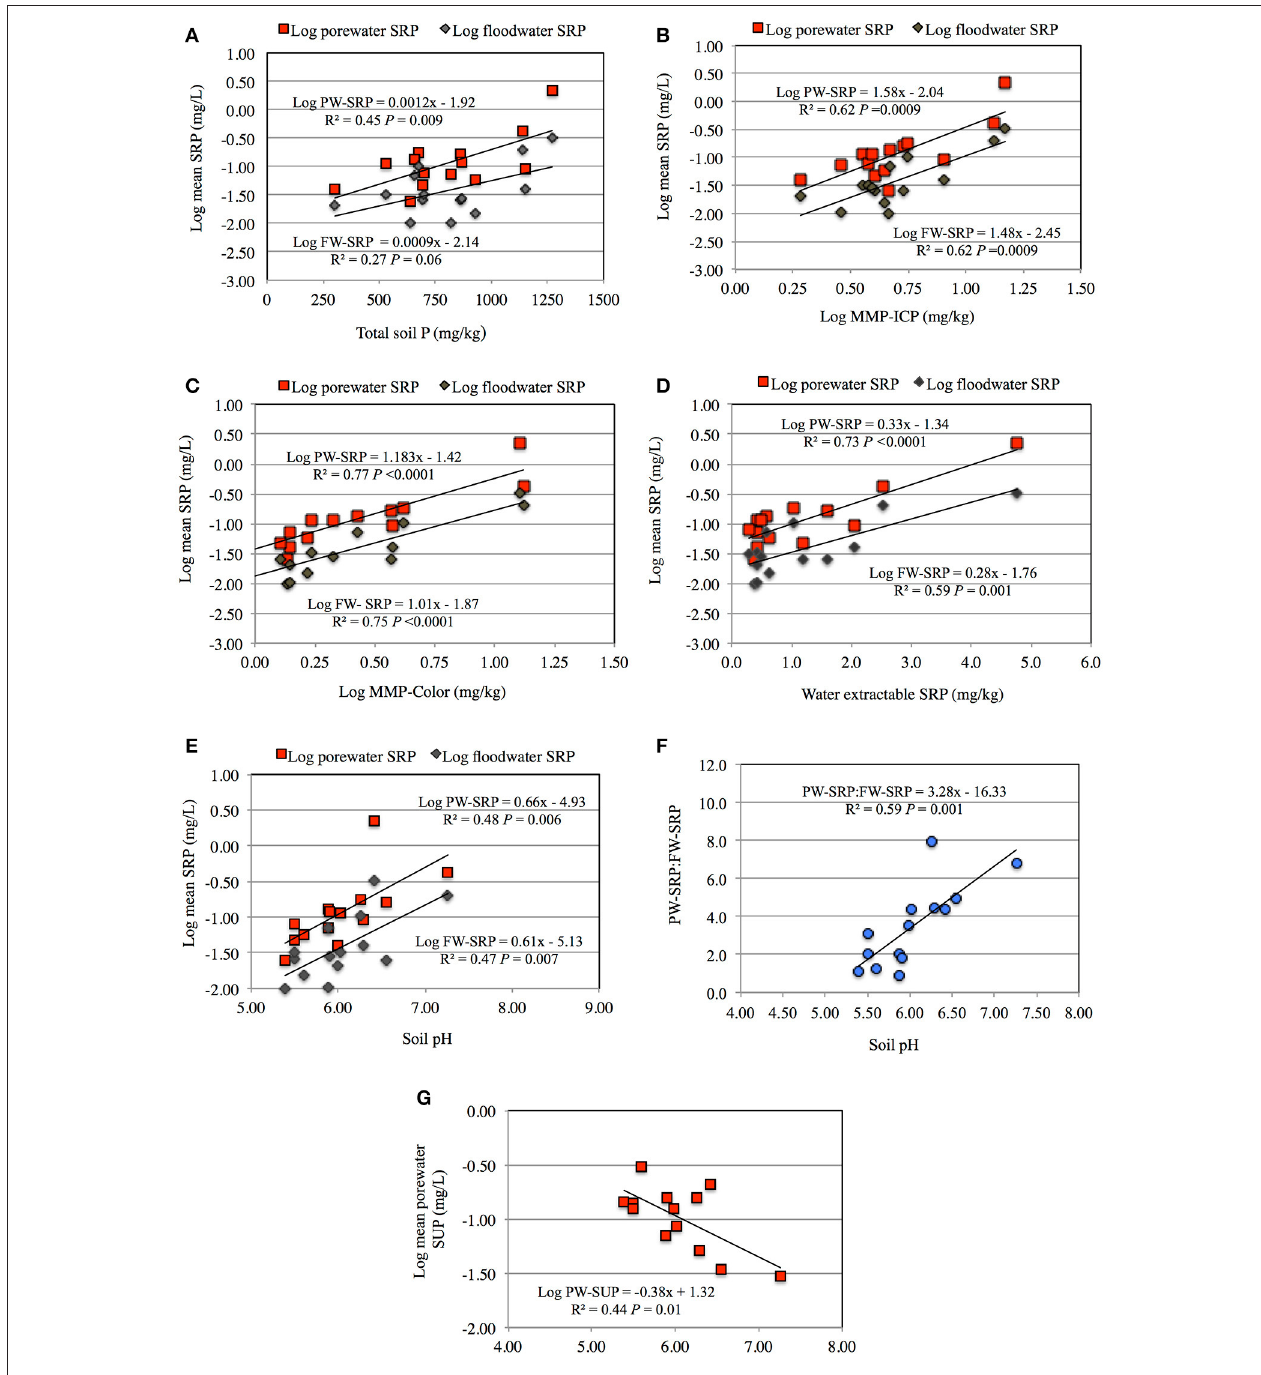
FIGURE 2 | Porewater soluble reactive phosphorus (PW-SRP) and floodwater soluble reactive phosphorus (FW-SRP) averaged over the study period ( n = 8) as a function of total soil phosphorus (A) , modified Morgan extractable soil P measured by ICP (MMP-ICP) (B) , modified Morgan extractable P measured by the molybdate colorimetric procedure (MMP-Color) (C) , water extractable soluble reactive phosphorus (D) and soil pH (E) . Mean ratio of PW-SRP to FW-SRP over the study period as a function of soil pH (F) and average PW-soluble unreactive P (SUP) as a function of soil pH (G) .